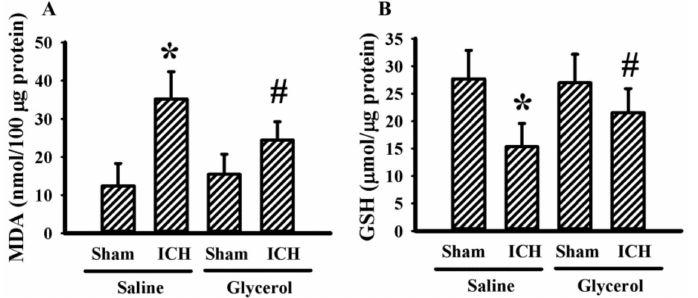
Figure 6. Glycerol alleviated kidney oxidative stress in hemorrhagic stroke rats. ICH and sham rats were intraperitoneally injected with saline or glycerol and housed for an additional 24 h. Kidney cortical tissues were isolated and subjected to the measurement of MDA ( A ) and GSH ( B ) * p < 0.05 vs. sham/saline and # p < 0.05 vs. ICH/saline, n = 8.